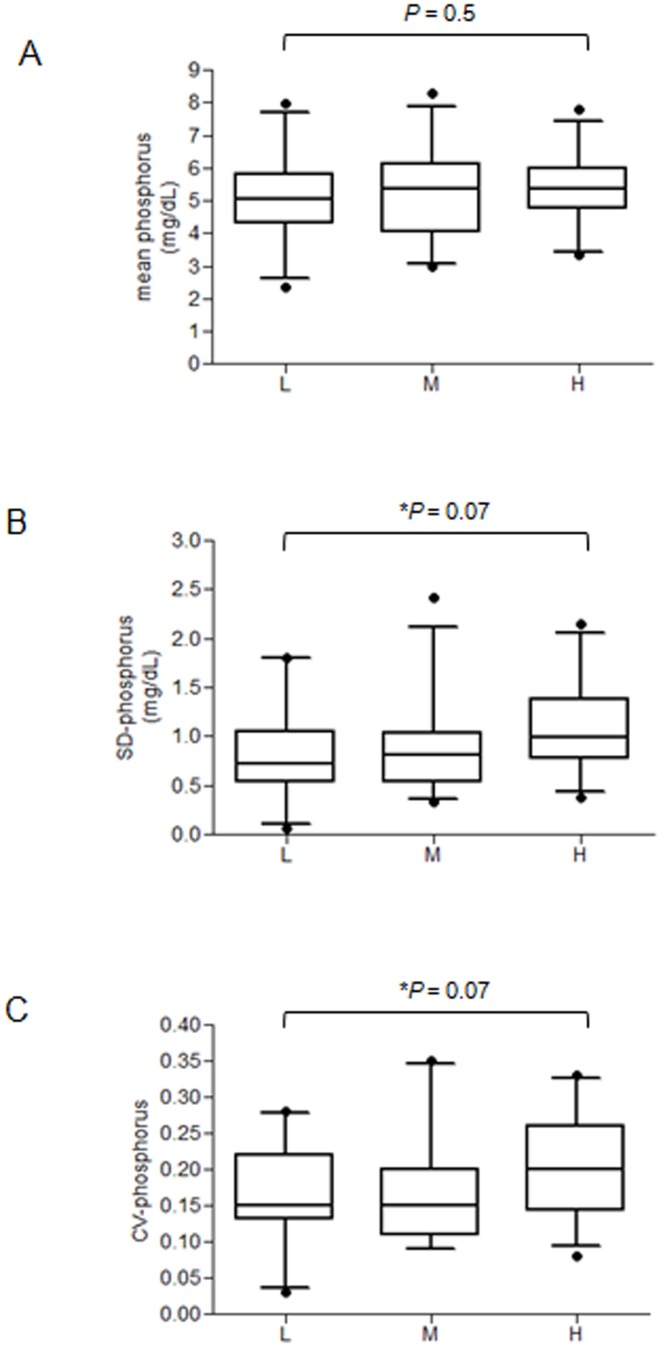
Boxplots of mean serum phosphorus (A), SD of serum phosphorus (B), and CV of serum phosphorus (C) in the three groups.The mean, SD, and CV were calculated from the past 6 follow-up values (April 2009 to July 2010). Data were compared by univariate ordinal logistic regressions. *
P<0.2. Box: interquartile range; upper and lower lines: 75th and 25th percentiles; central horizontal line: median; vertical whiskers above and below the boxes: 5th and 95th percentiles; circles beyond the whiskers: outliers.